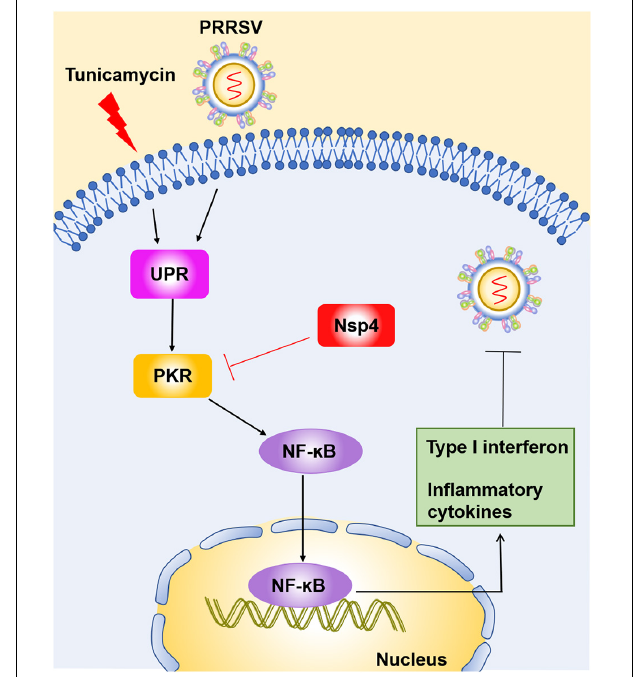
FIGURE 8 | Schematic model of the inhibition of PRRSV by UPR induction. PRRSV infection and tunicamycin stimulation induce UPR. The induction of UPR affects the expression of PKR, which activates NF- κ B signaling and interferon response at the early stage of PRRSV infection. Elevated type I interferons and proinflammatory cytokines are highly correlated with the reduction of PRRSV replication. Simultaneously, PRRSV Nsp4 can decrease the expression of PKR protein, indicating PRRSV evades the host immune responses via a new